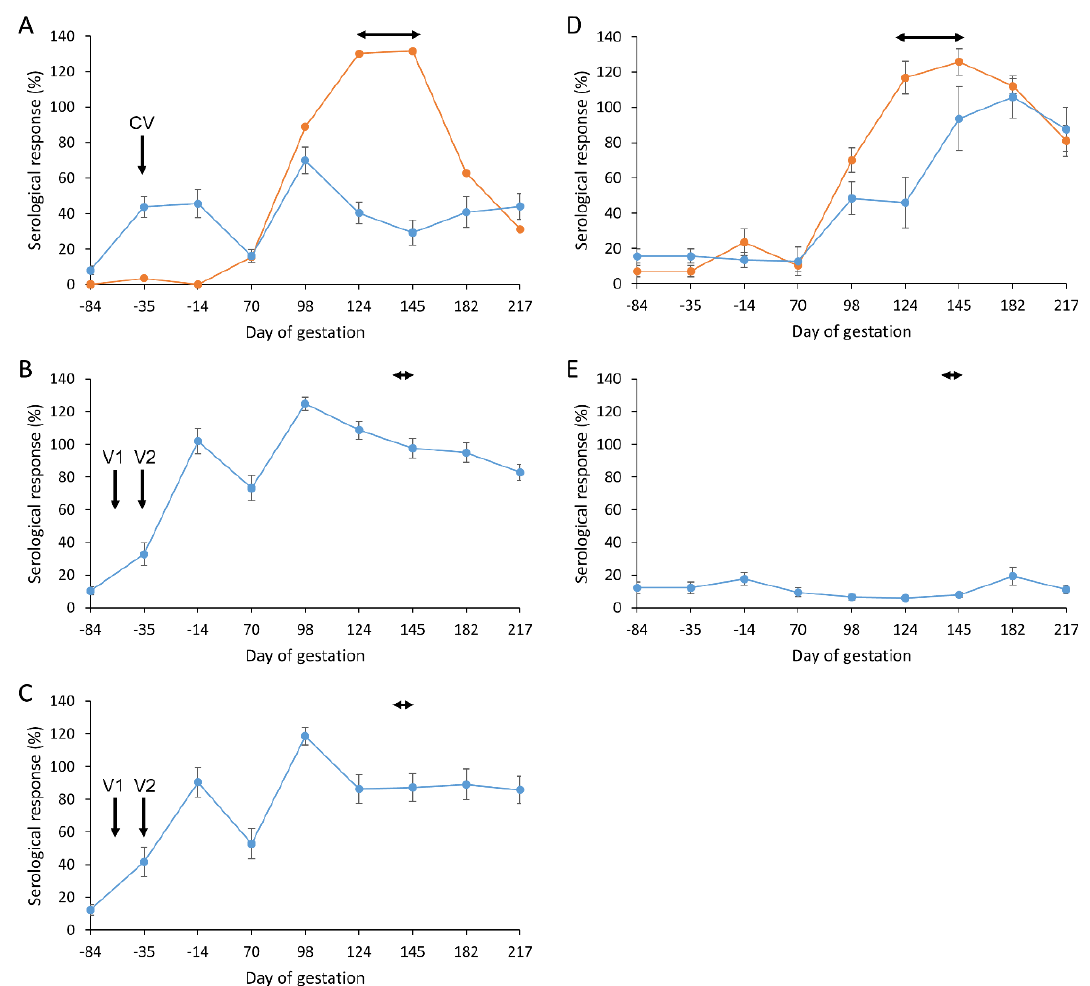
Figure 2. Serological responses following vaccination and challenge with Chlamydia abortus . Detection of C. abortus antibody in ewes vaccinated (V1 and CV/V2—see Figure 1) with commercial vaccine 1 ( A ) or experimental vaccines 2 ( B ) and 3 ( C ) and challenged at day 70 of gestation with C. abortus strain S26/3. Unvaccinated challenged ( D ) and unvaccinated non-challenged ( E ) ewes served as positive and negative control groups. Data are separated into lambed (blue lines) versus aborted (orange lines). Data points represent the arithmetic mean values for each cellular bleed and error bars represent the standard error of that mean (SEM). The 100% is equivalent to an OD450 nm of 2.25. The lambing/abortion period is indicated by the horizontal double-headed